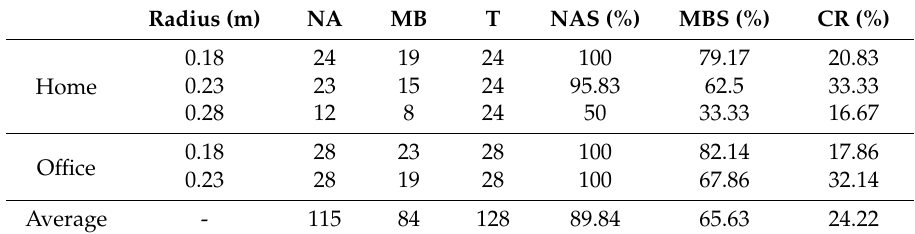
Table 4. Results of crossing door success